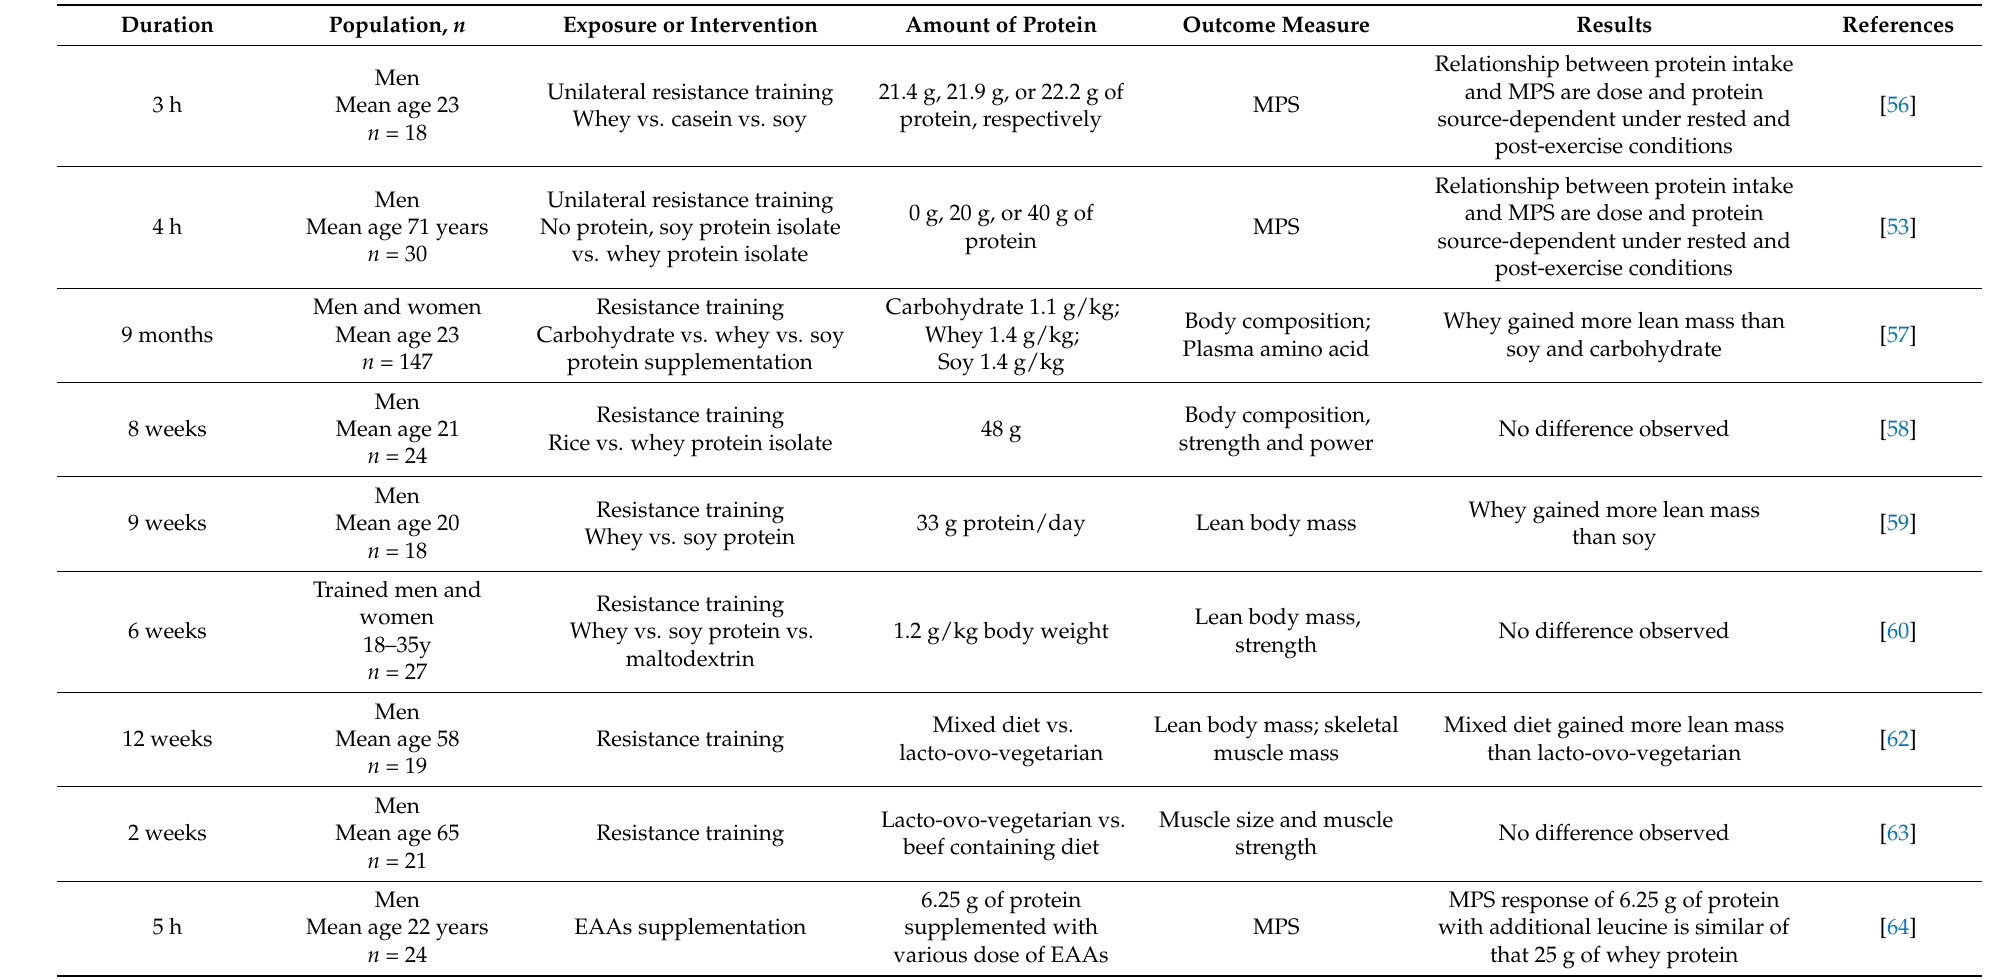
Table 1. The effect of dietary protein supplementation by source and essential amino acid content on muscle outcomes in clinical